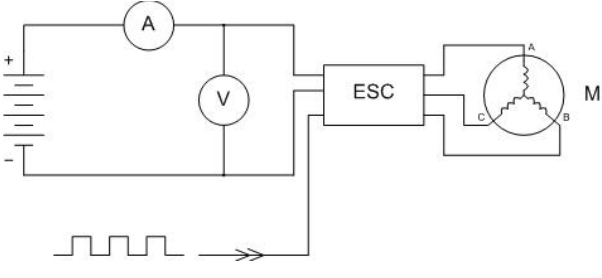
Fig. 6. Schematics of UAV traction drive